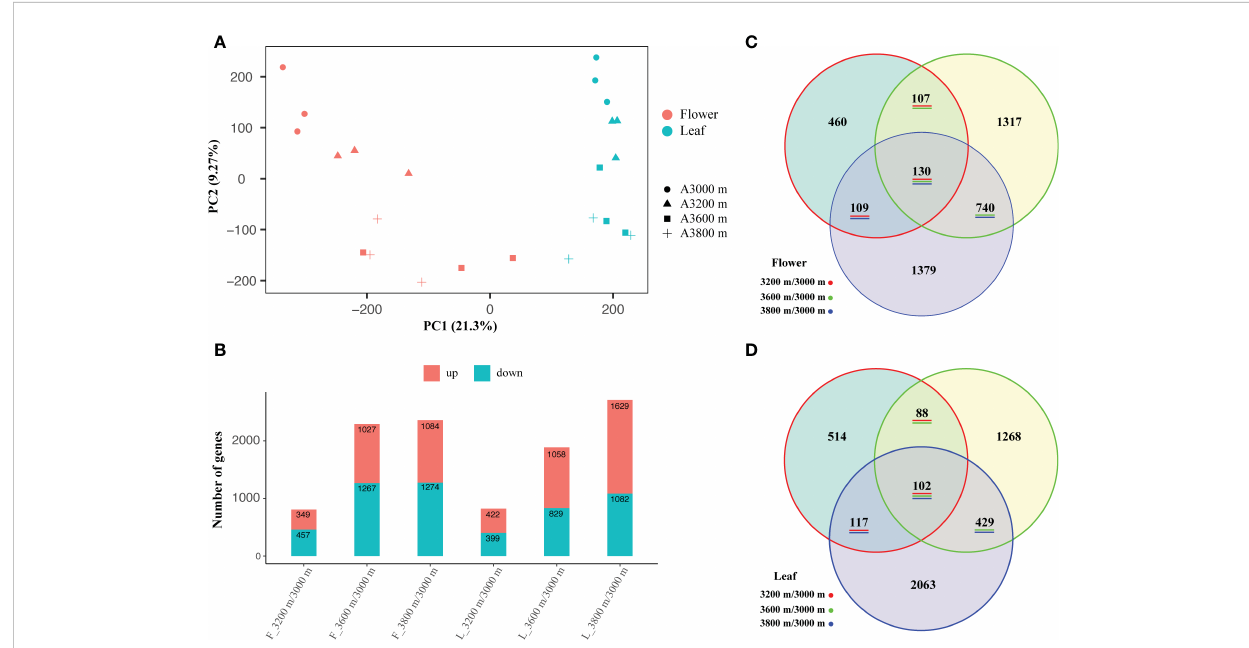
FIGURE 2 Principal component analysis (PCA) of 24 individuals of the R . sanguineum var. haemaleum (A) , and the number statistics (B) and Venn diagrams (C, D) of differentially expressed unigenes (DEUs) among three different comparisons in late fl ower and early leaf bud,